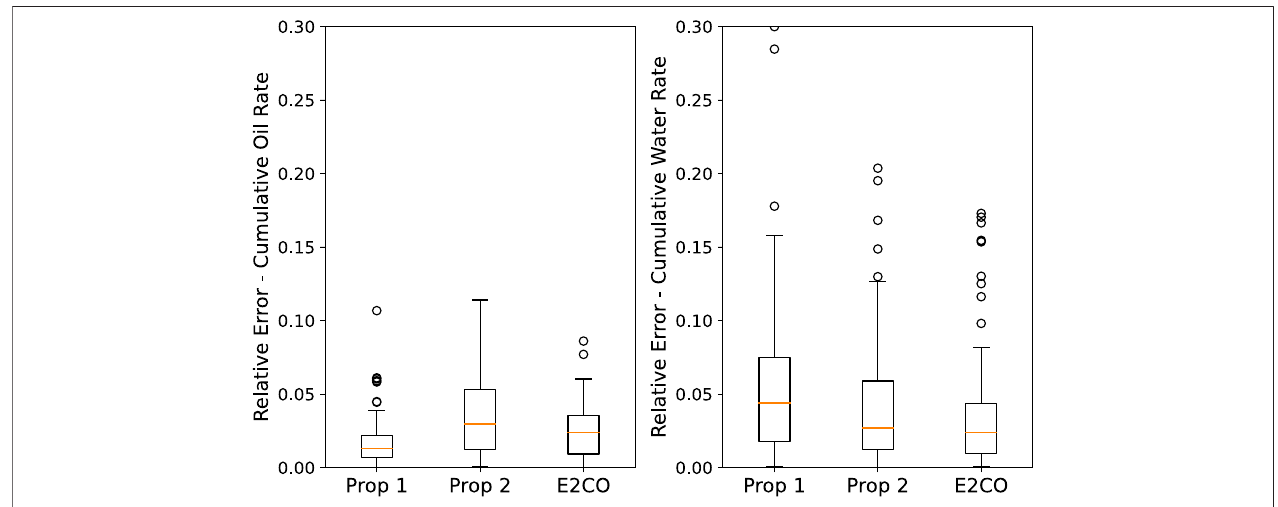
FIGURE 17 | Validation set error for cumulative oil (left plot) and cumulative water (right plot) production.